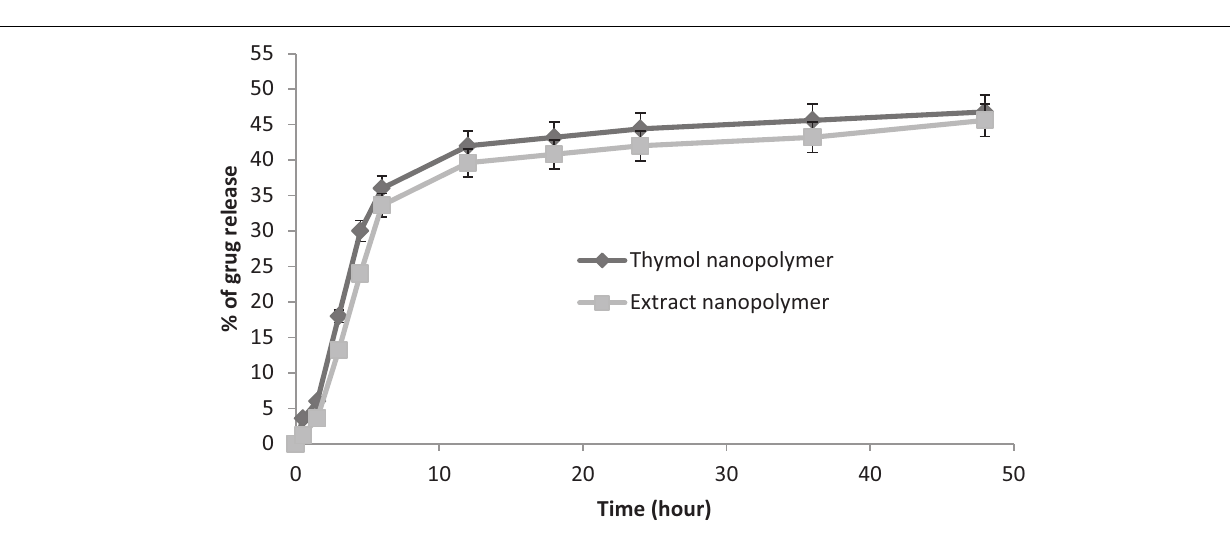
Frontiers in Behavioral Neuroscience |